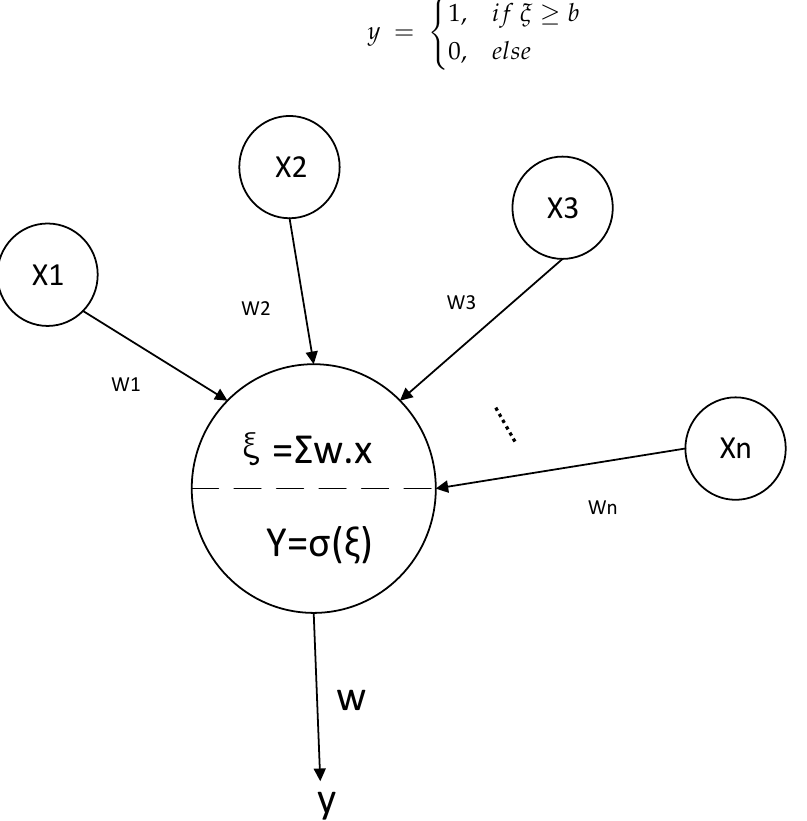
Figure 4. M (McCullough)–P (Pitts) neuron model.